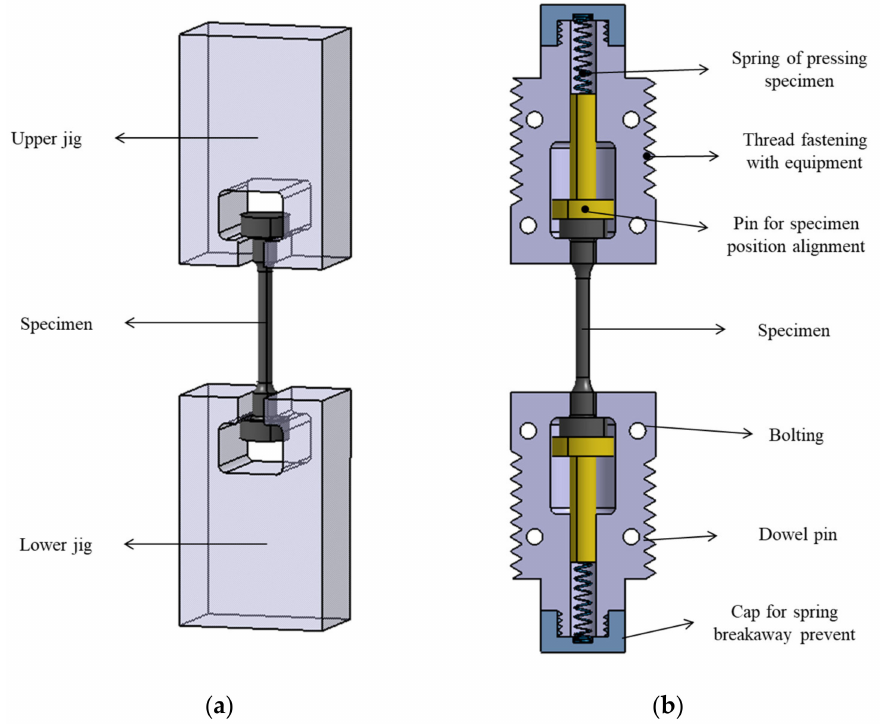
Figure 2. Schematic of a jig for high-strength tensile tests: ( a ) conventional jig and ( b ) proposed jig.